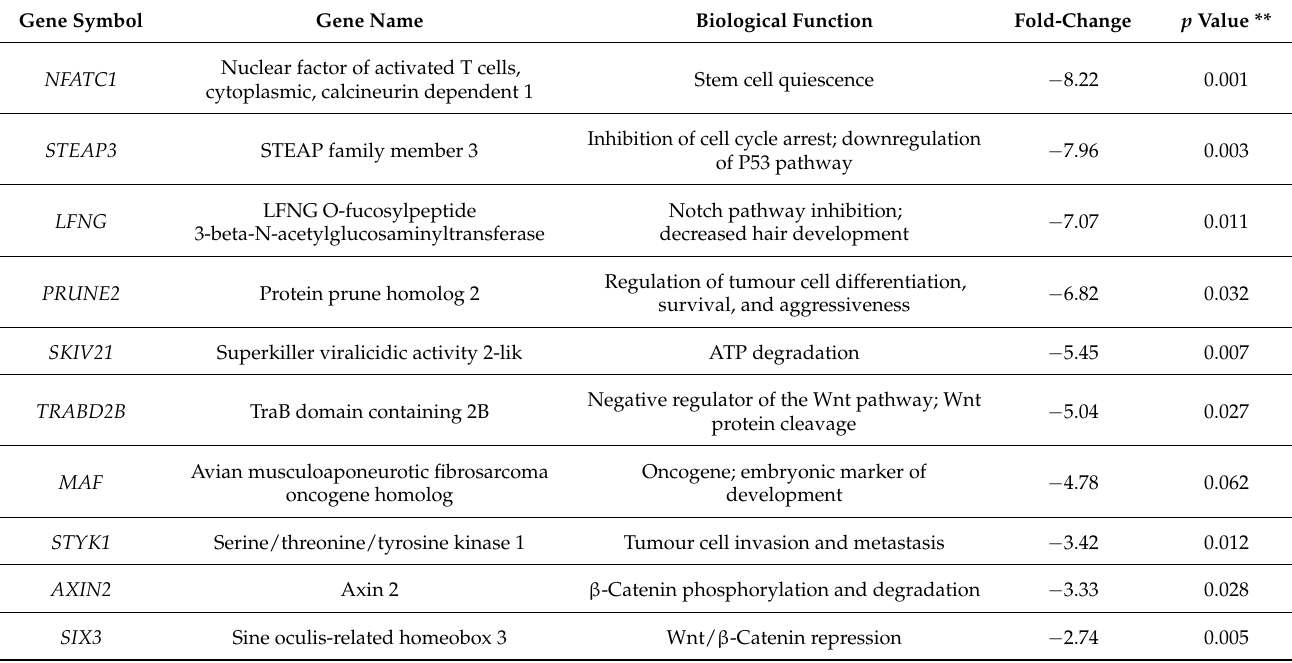
Table 3. The top downregulated genes in the 3D minoxidil-treated cells (vs. 3D control)